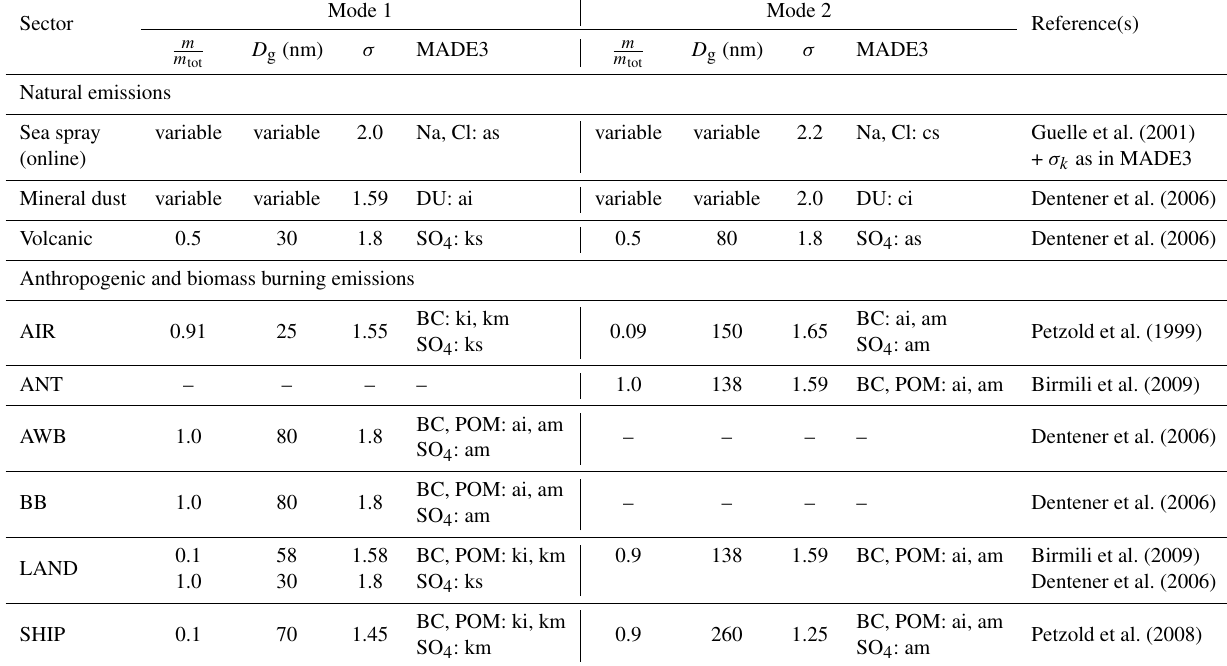
Table 2. Size distributions assumed for emitted particles. The term m specifies the mass fraction provided by the respective measured or m tot prescribed mode; D g and σ specify, respectively, the median diameter and geometric standard deviation of the lognormal distributions used to describe the number size distributions of the modes. The “MADE3” columns show the species and modes to which the emissions are assigned. The mode naming convention follows Kaiser et al. (2014): one of the indices “k”, “a”, or “c” is used to specify the Aitken, accumulation, or coarse mode, respectively, and “s”, “m”, or “i” as a second index specifies the soluble, mixed, or insoluble mode, respectively. The value “variable” in the mass fraction and median diameter columns indicates that both number and mass emissions are provided by the emission data source, so that number emissions do not have to be derived from the mass emissions. The emission sectors are abbreviated as follows: “AIR” for aviation, “ANT” for anthropogenic non-traffic, “AWB” for agricultural waste burning, “BB” for biomass burning, “LAND” for land transport, and “SHIP” for